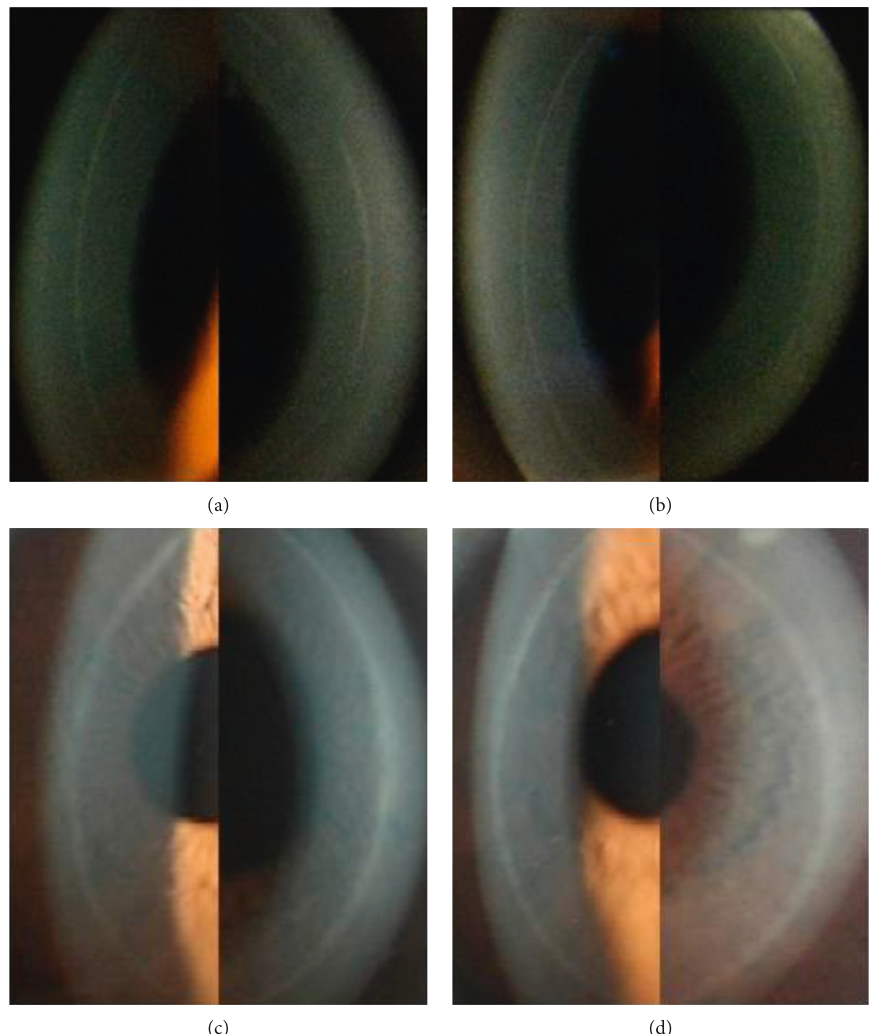
Figure 1: Corneal flap margin and adjacent regions photographed by slit-lamp biomicroscopy at 6 months after surgery. Smooth, narrow, moderately reflective circumferential bands in the control right eye (a) and the BCL-treated left eye (b) of a patient. Smooth, slightly wider circumferential bands in the BCL-treated right eye (c) and the non-BCL-treated left eye (d) of a